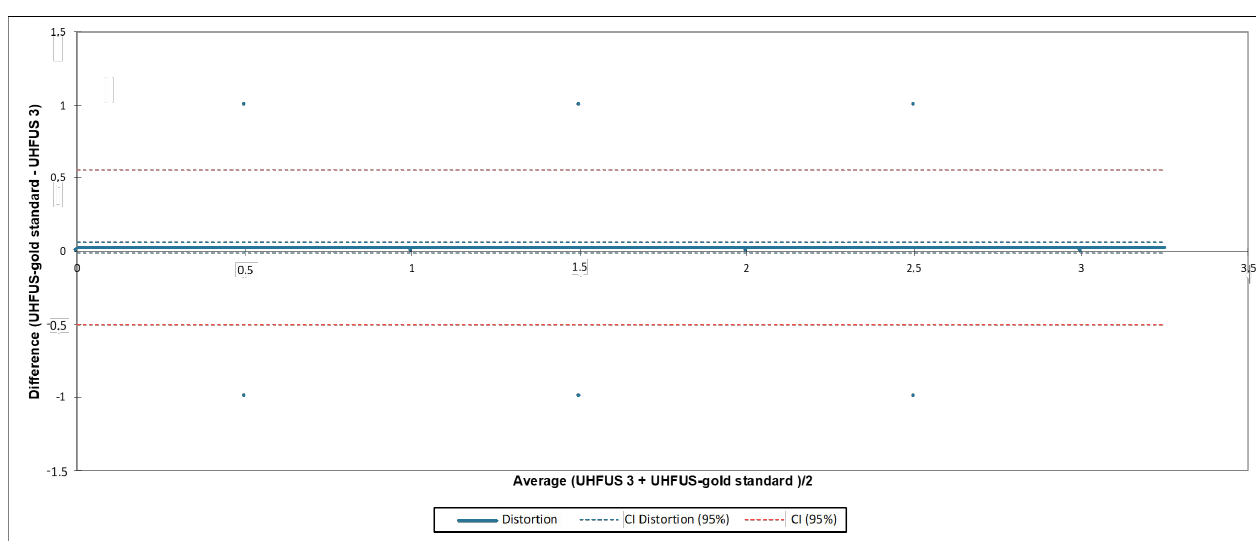
Figure 4. Bland-Altman test evaluating the agreement between the third reader (UHFUS 3) and gold standard examiner (UHFUS-gold standard). The 95% confidence interval (CI) of the distortion was ( − 0.012;